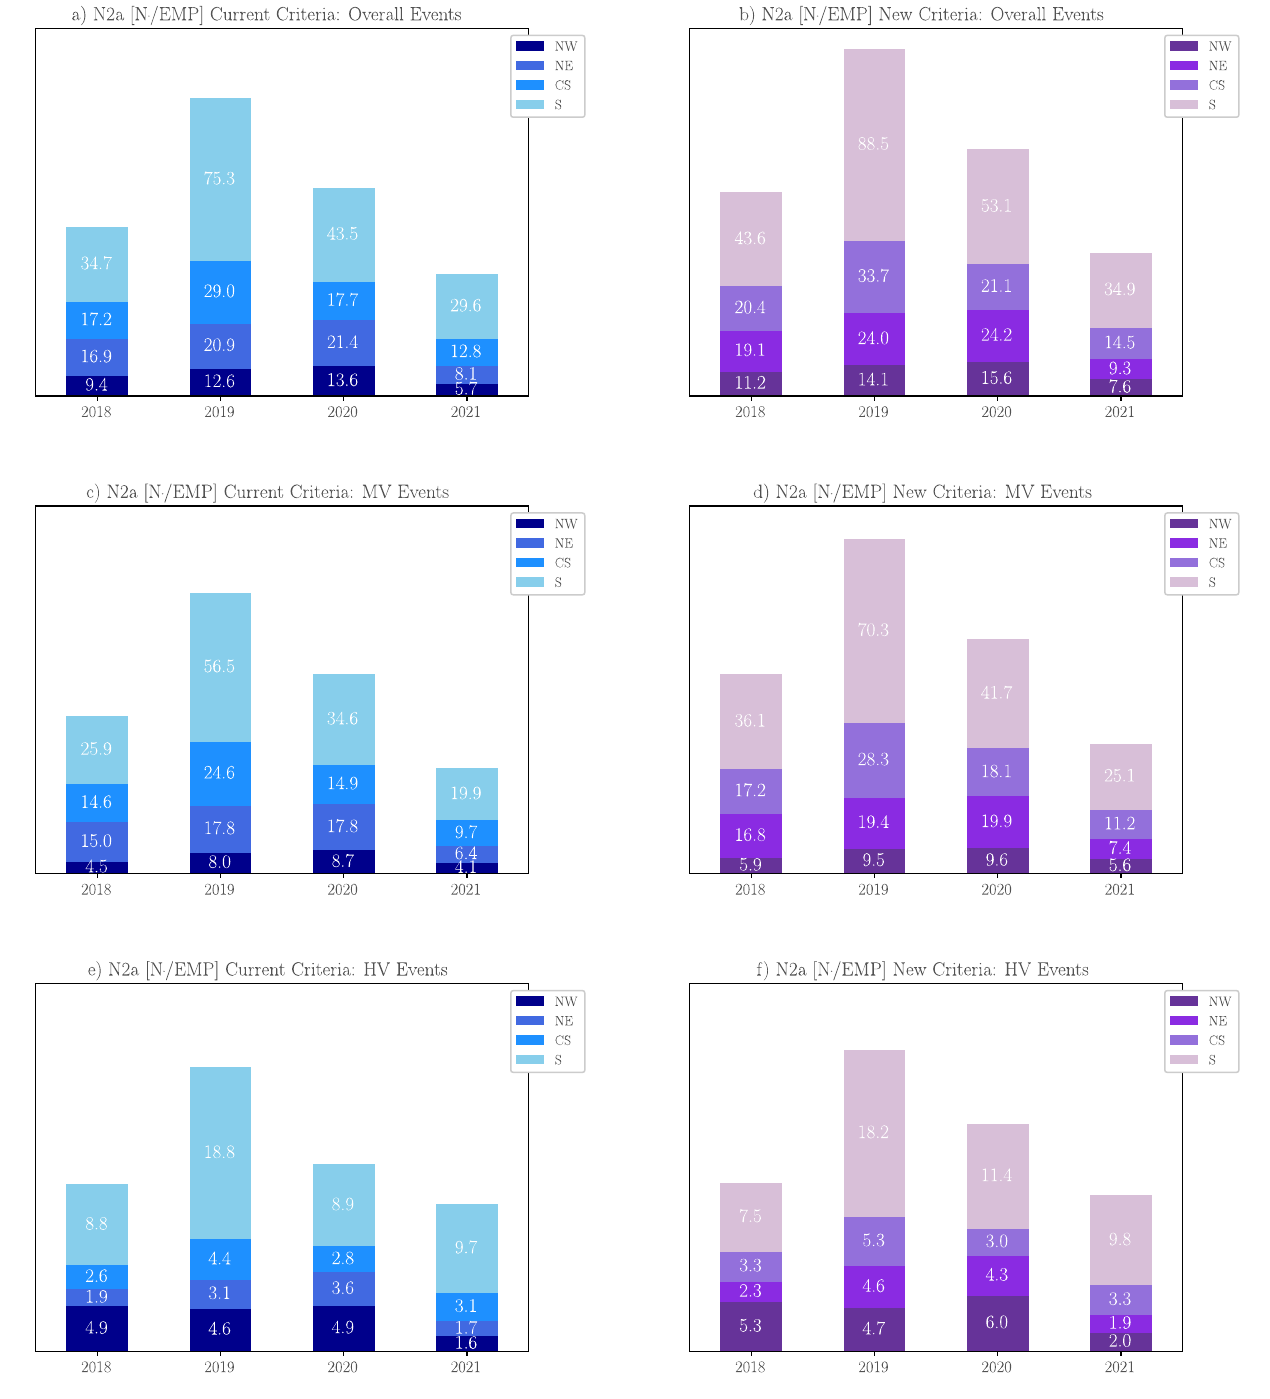
Figure 13. ( a ) current criteria N2a: overall events; ( b ) new criteria N2a: overall events; ( c ) current criteria N2a: MV events; ( d ) new criteria N2a: MV events; ( e ) current criteria N2a: HV events; ( f ) new criteria N2a: HV events.